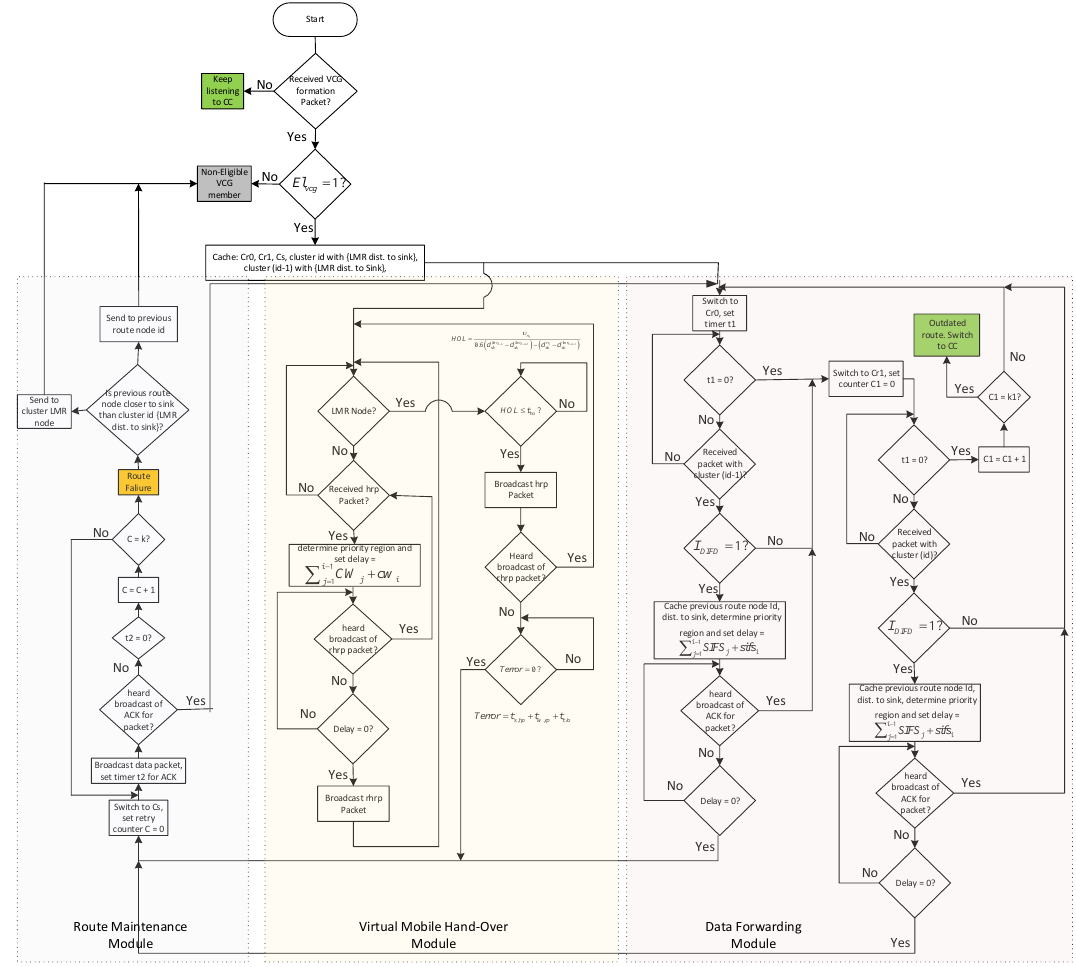
Figure 9. Flow chart for the MROR node forwarding algorithm. CCC, control channel; SIFS, short inter-frame space; DIFD, data initiative forwarding